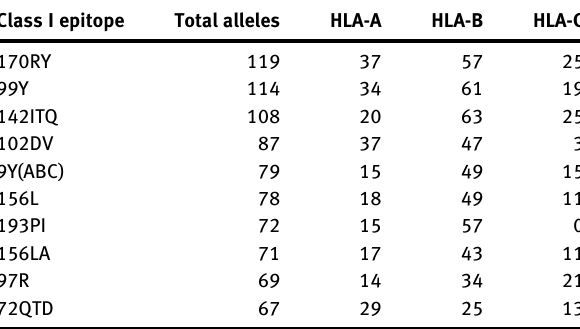
Table  : Most shared epitope list by class I